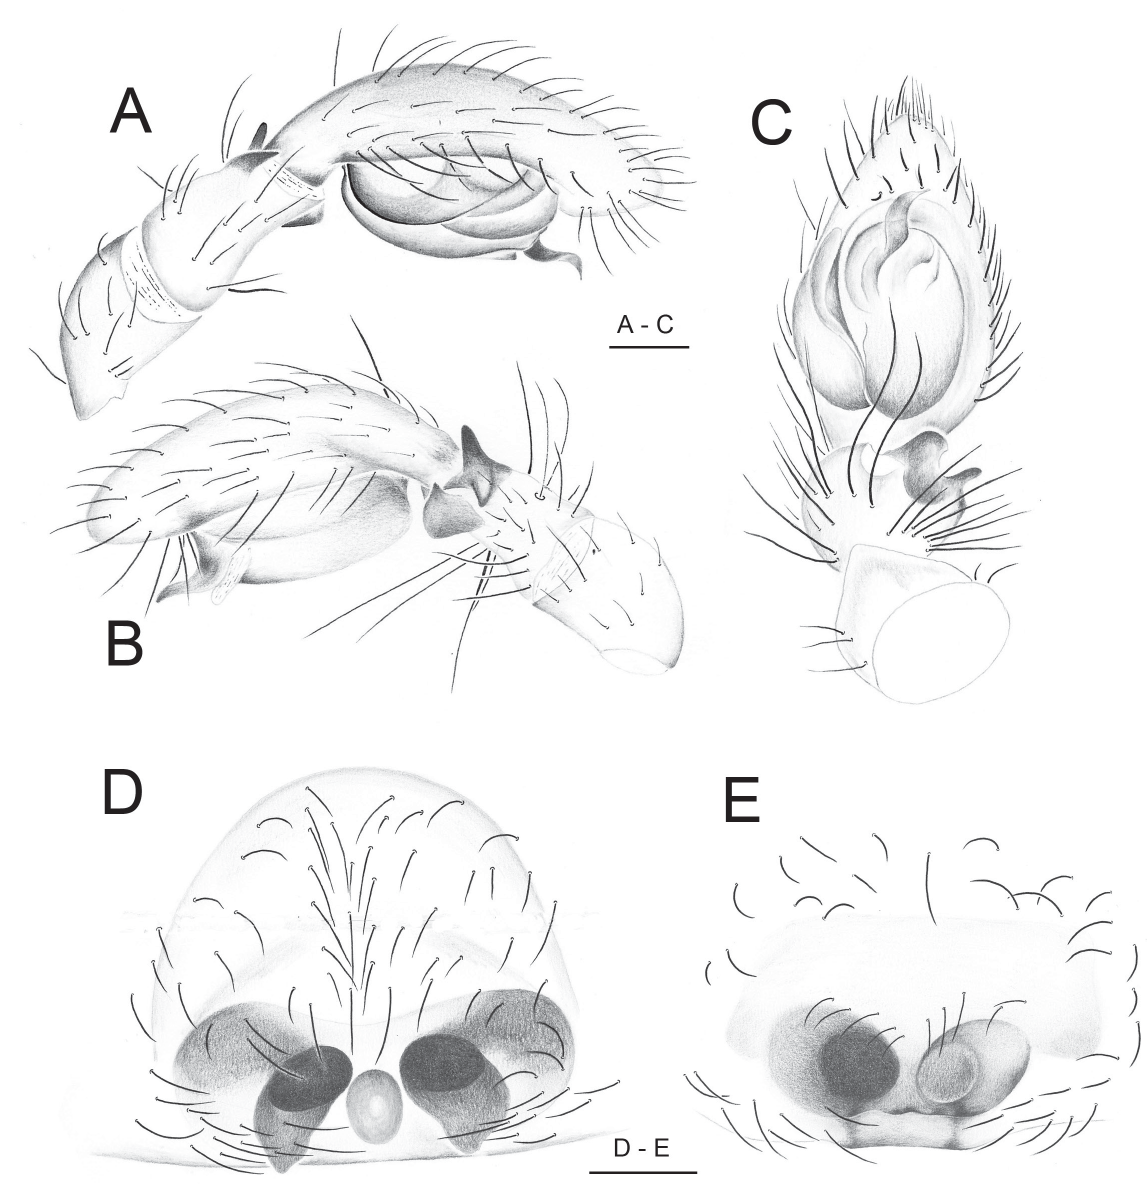
Fig. 5. A–D . Chumma interfluvialis sp. nov. A–C . Holotype, ♂. A . Palp, prolateral view. B . As preceding, retrolateral view. C . As preceding, ventral view. D . Paratype, ♀, epigyne, ventral view. – E . Chumma lesotho sp. nov., holotype, ♀, epigyne, ventral view. Scale bars: 0.2